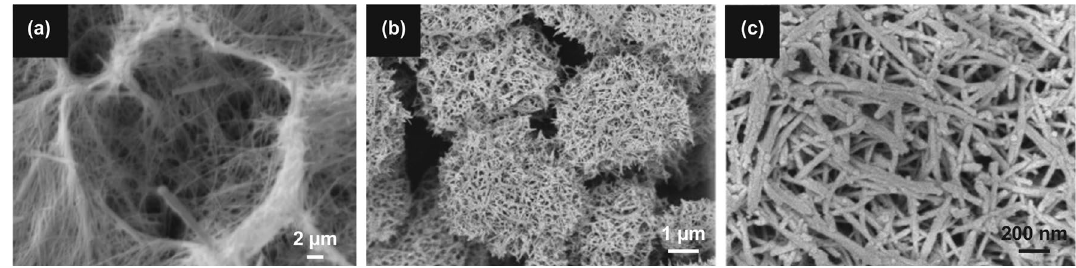
Fig. 10 a SEM image of nest-like The Ni@Ni 1.4 Co 1.6 S 2 . Reproduced with permission from Ref. [138]. Copyright 2015, Royal Society of Chemistry. b‑c SEM image of nest-like structures based from MnO 2 . Reproduced with permission from Ref. [139]. Copyright 2013,